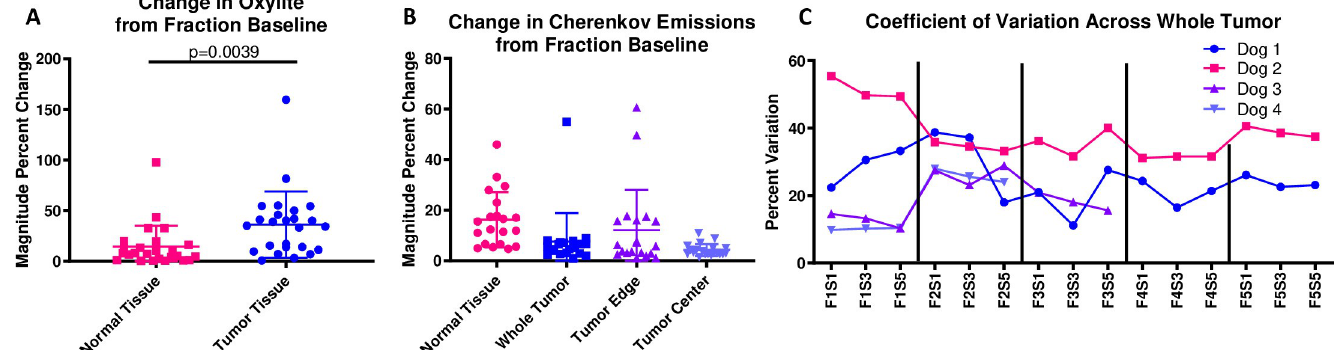
Fig 6. Summary of percent change from fraction baseline for included canine subjects. For each fraction FN, the magnitude of the percent change was calculated for three canine subjects and combined into a single graph. A) The Oxylite data for normal tissue and tumor tissue are significantly different according to a two-tailed, paired T-test with p = 0.0039. Though the Oxylite data is only a point measurement, it is clear that tissue oxygen levels are changing more in the tumor than in the normal tissue. B) The Cherenkov data shows that the absolute percent change for the tumor edge is the largest. The normal tissue also changes from baseline while the whole tumor and tumor center does not change as much, relative to the other tissue areas. C) The coefficient of variation was calculated for each whole tumor over the course of the entire radiation plan for a single gantry angle (standard deviation / mean). Not only is there high pixel-pixel variation, but that variation changes for a single